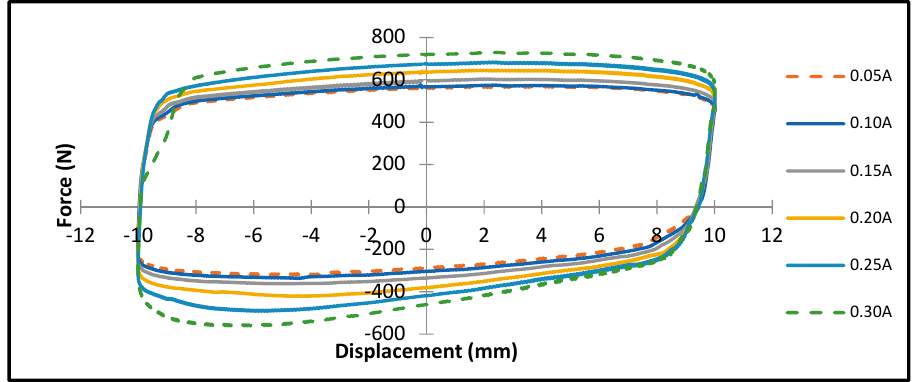
Figure 14. Damping force versus piston velocity at the higher current (measured).